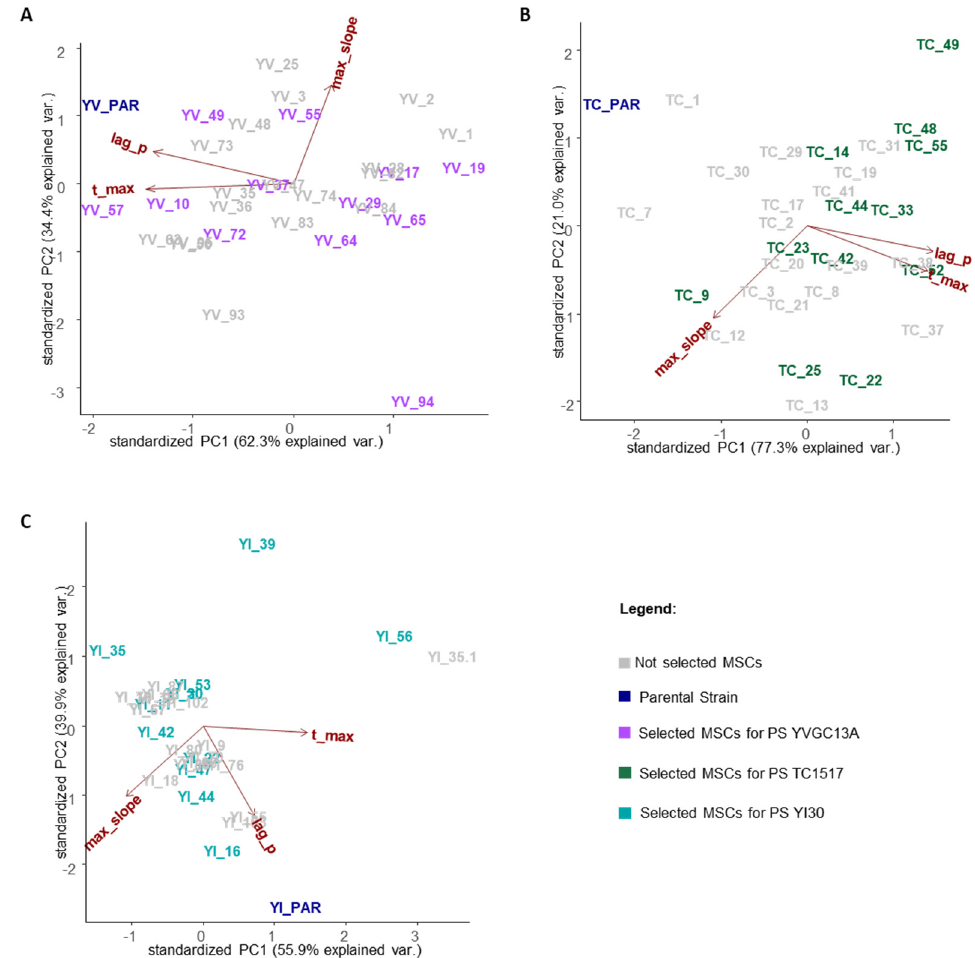
Figure 3. PCA biplot of growth parameters obtained from the 30 MSCs selected from the sporulation of each S. cerevisiae parental strain. Input variables: Lag, t_max and max_slope growth parameters obtained using the pyphe-growthcurves tool from for 30 MSCs of the parental S. cerevisiae strain YVGC13A ( A ), TC1517 ( B ) and YI30 ( C ). Parental strains are reported in blue, not selected MSCs cultures in grey and the twelve MSCs cultures selected for the next step of the analysis in violet ( A ), green ( B ) and light blue ( C ).